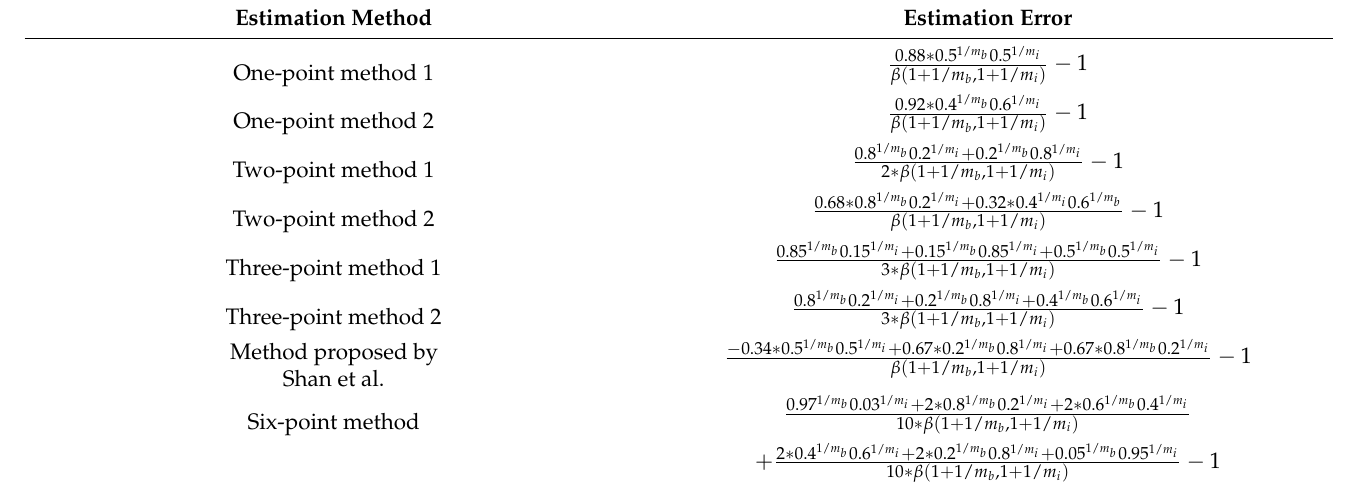
Table 2. Estimation method and errors of depth-averaged velocity.